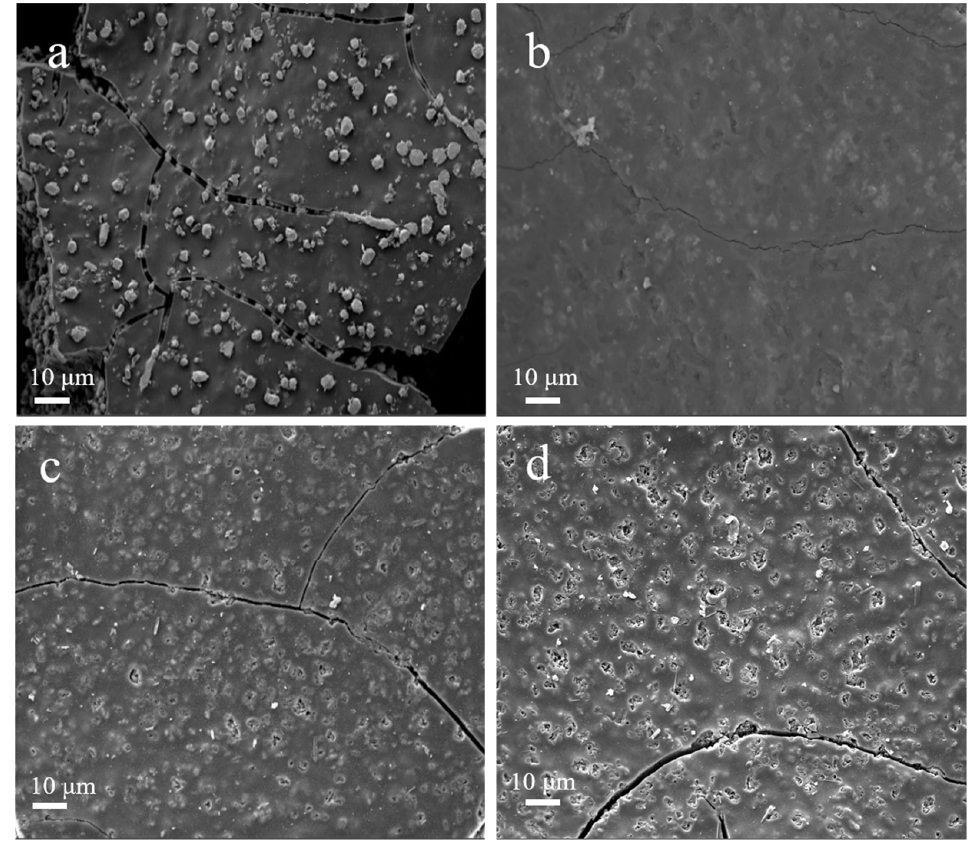
Figure 6. FE-SEM image of ( a ) Cu@N-C(600), and used Cu@N-C(600) ( b ) the first run, ( c ) the second run, and ( d ) the fourth run.